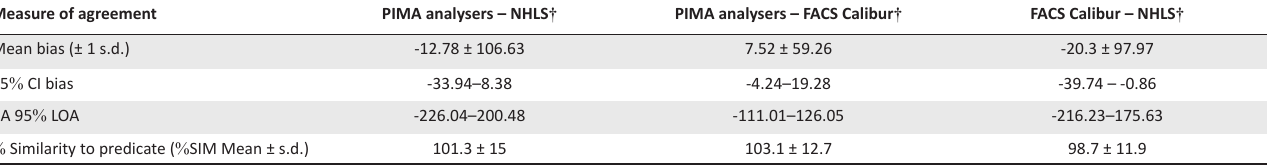
TABLE 2: Bland–Altman comparison of PIMA TM analysers versus National Health Laboratory Services versus FACS Calibur. Measure of agreement